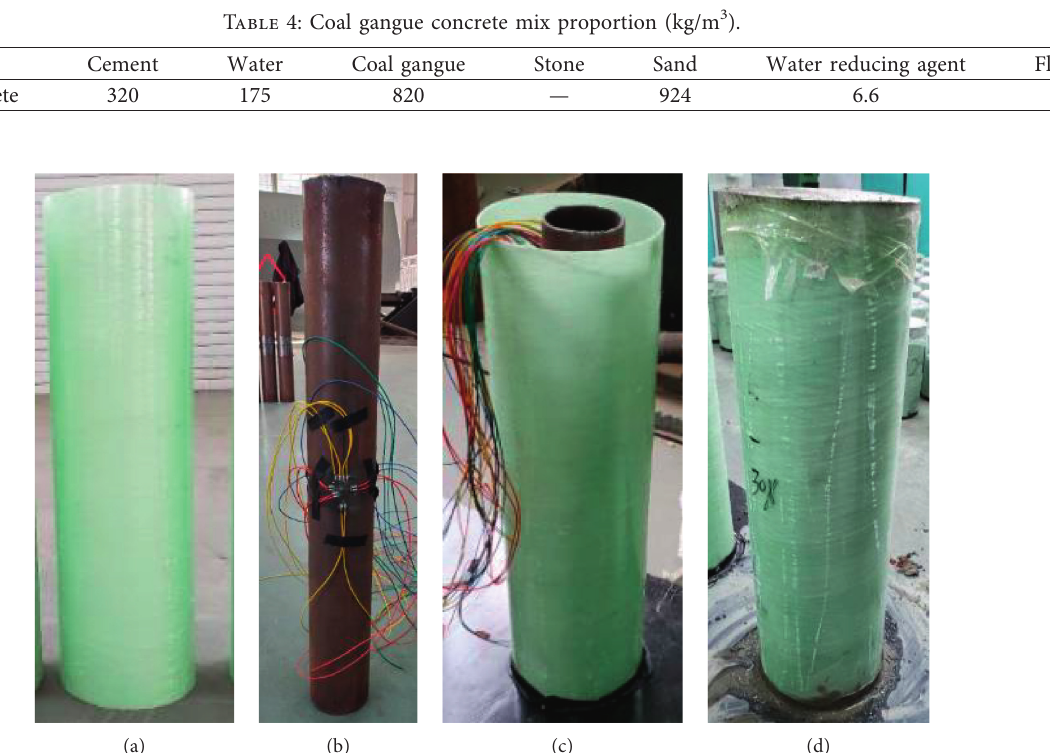
Figure 6: Component production process. (a) Glass fiber tube. (b) Steel tube. (c) Parts assembly. (d) Finished specimens.